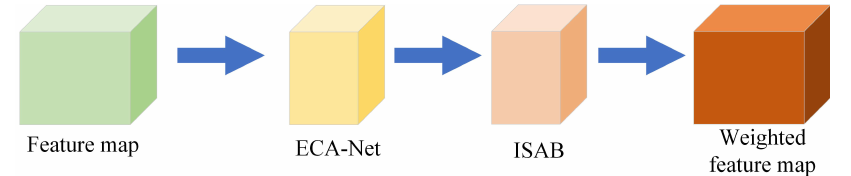
Figure 4. The structure of the attention mechanism proposed in this paper.